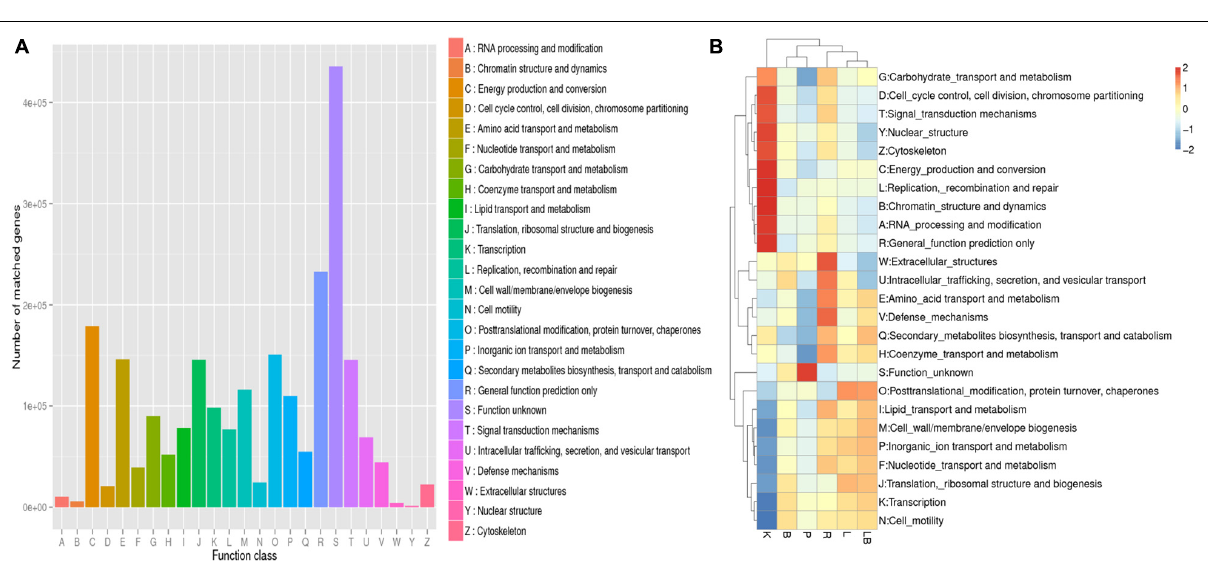
FIGURE 3 | Non-supervised Orthologous Groups (EggNOG) annotation analysis of samples from freshwater benthic biofilms. (A) Numbers of genes matched to the EggNOG database in the combined column- and organic isolation-based groups. (B) Functional annotation analysis of the relative abundances in the six extraction groups, based on EggNOG database level 1 including 24 taxa. Abbreviations of extraction groups denote, K: Column-based kit isolation; R: RNAzol only group; B: Bead-beating group; L: Lysozyme group; P: Cell disruption bomb; LB: Lysozyme + Bead-beating